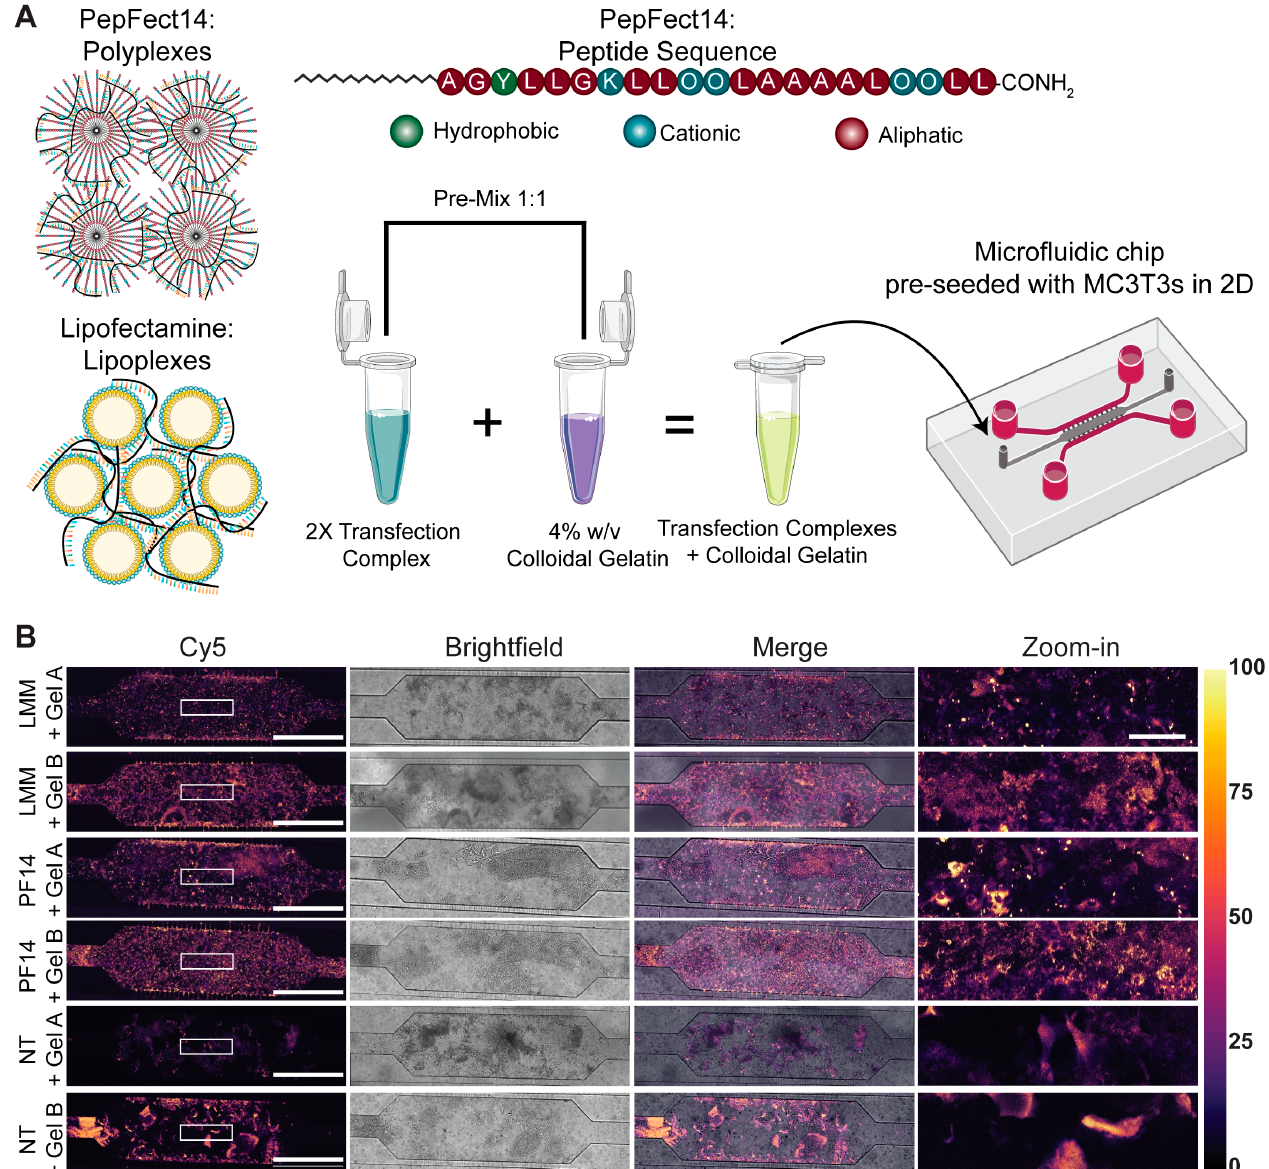
Figure 2. Uptake of mRNA transfection complexes in the presence of colloidal gelatin. ( A ) Schematic overview of mRNA transfections in the presence of colloidal gelatin within a microfluidic chip. PF14 forms micelles due to its stearyl moiety, and due to its positive charge, it electrostatically complexes mRNA into polyplexes. LMM lipoplexes are pre-formed lipid micelles that complex mRNA via their cationic lipid head groups. Image not drawn to scale. ( B ) Confocal microscopy images of uptake into MC3T3 cells two hours post-transfection, where the Cy5-label of Cy5-eGFP mRNA is visualized. For enhanced clarity, an enlarged region of interest, which corresponds to the white rectangle (width: 736 µm, height: 209 µm) in the leftmost column, is shown in the rightmost column. The untreated conditions were used as negative controls to assess the autofluorescence of colloidal gelatin. The mpl-inferno LUT depicts the Cy5 intensity, and all Cy5 images were calibrated equally across conditions. Scale bars represent 1000 µm; scale bars in zoom-in panels represent 150 µm. Cy5, Cyanine5; NT, non-treated.